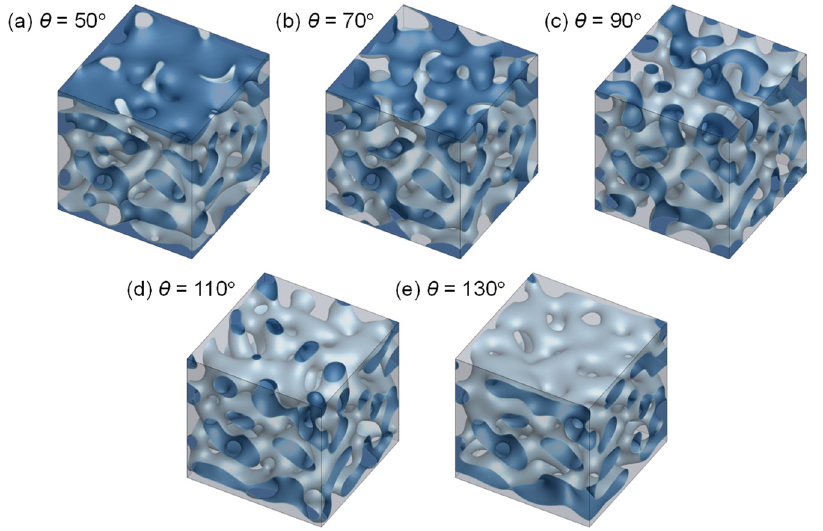
Figure 5. Effect of contact angle θ on the membrane structure. θ = ( a ) 50°, ( b ) 70°, ( c ) 90°, ( d ) 110°, and ( e ) 130°. t * = 0.8.